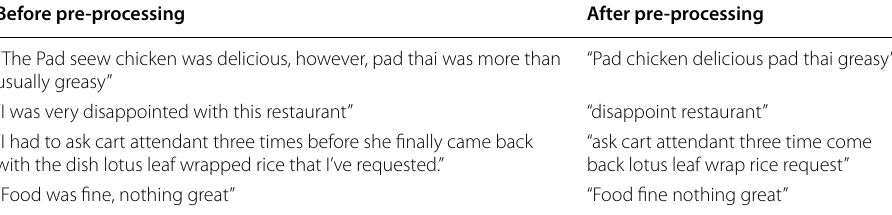
Table 1 Sample reviews before and after employing pre-processing algorithm Before